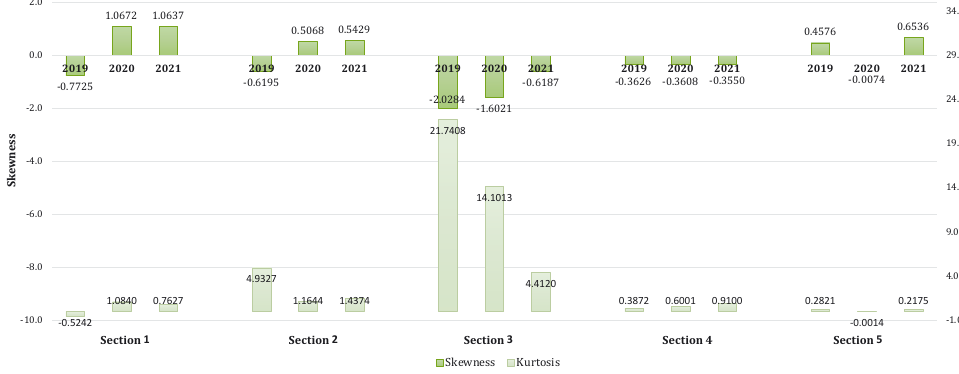
Figure 19. The change of the track gauge values of the selected sections over time, considering the skewness and kurtosis indicators